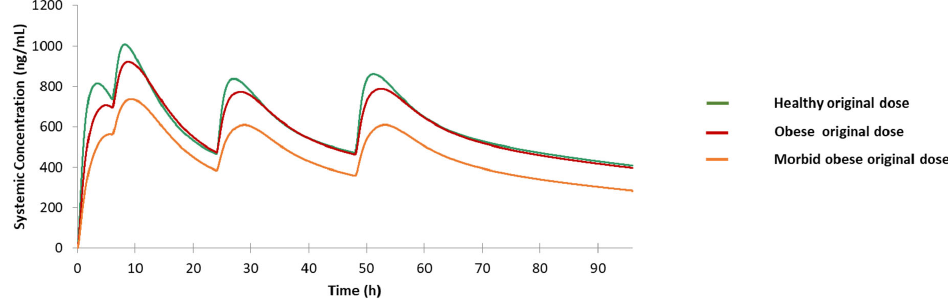
Figure 9. Predicted drug concentration for healthy population, obese population, and morbidly obese population under original dose. Table 3. The reported R 2 value from the five different regression models for the parameters of the morbidly obesity (MO) population and the drug peak concentration after each dosing. MO ‐ First Dose Exponential Linear Polynomial